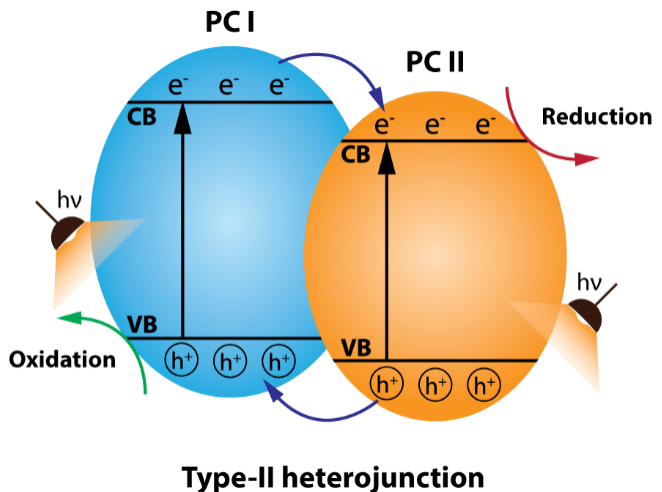
Figure 3. Representative charge-transfer route in the type-II heterojunction photocatalyst; CB—conduction band, VB—valence band, PC I—photocatalyst I, PC II—photocatalyst II (based on references [78,79]).